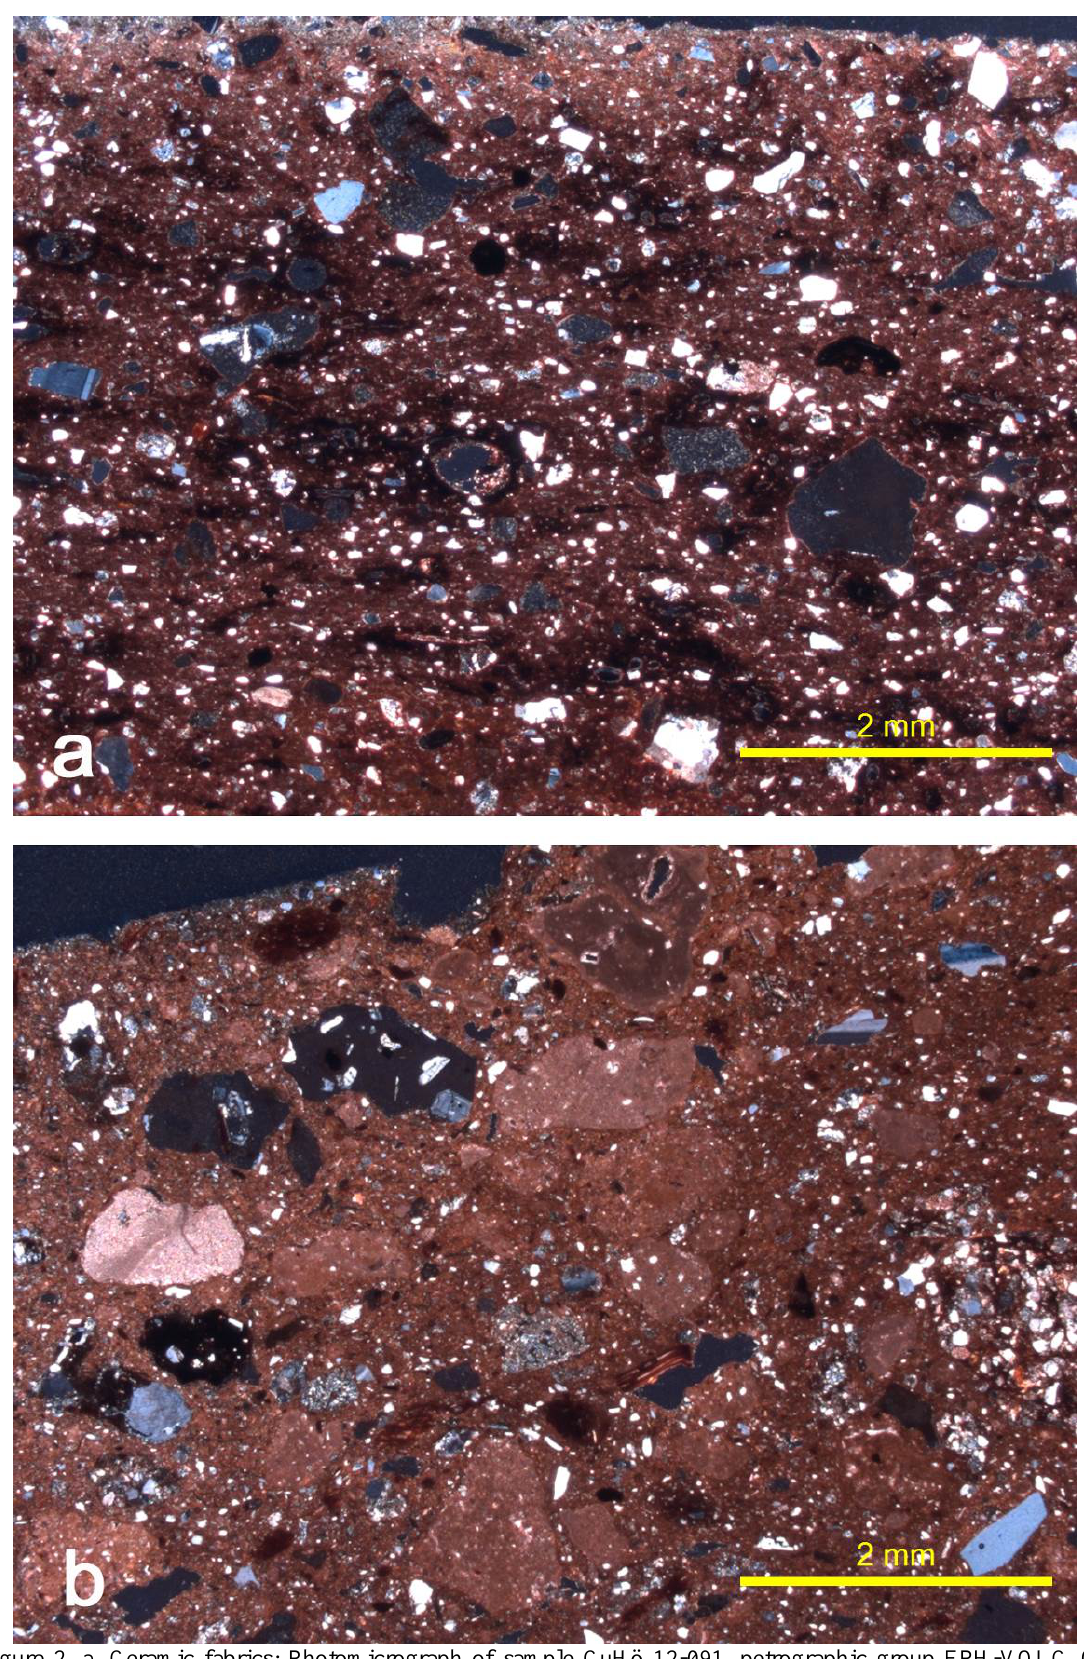
Figure 2. a. Ceramic fabrics: Photomicrograph of sample ÇuHö 12-091, petrographic group EPH-VOLC_08, crossed polars; b. Photomicrograph of sample ÇuHö13-016, petrographic group EPH-VOLC_07, crossed polars. Photos depicting volcanic rock fragments in a glassy matrix (both photos: L.